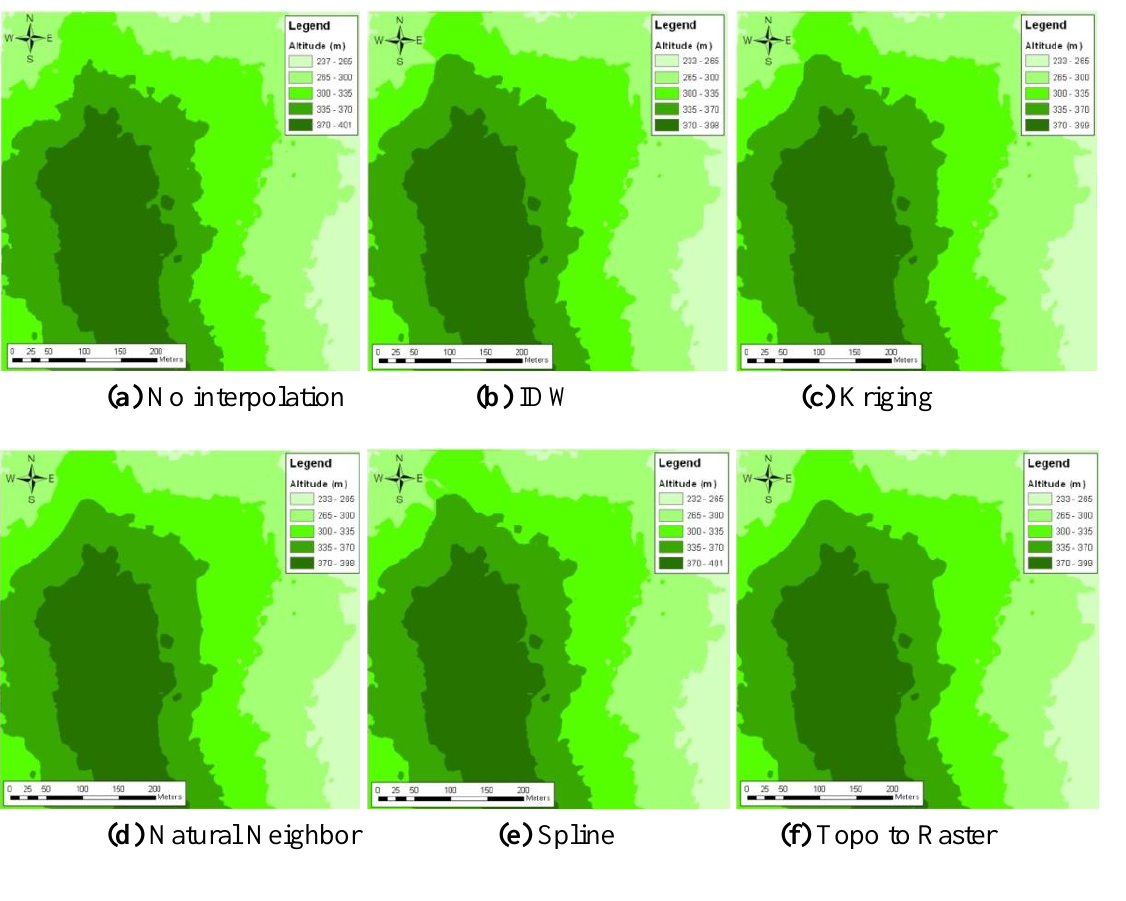
Figure 7. Interpolation of ANN projected DEMs of [min, max] DSMs range with the perimeter